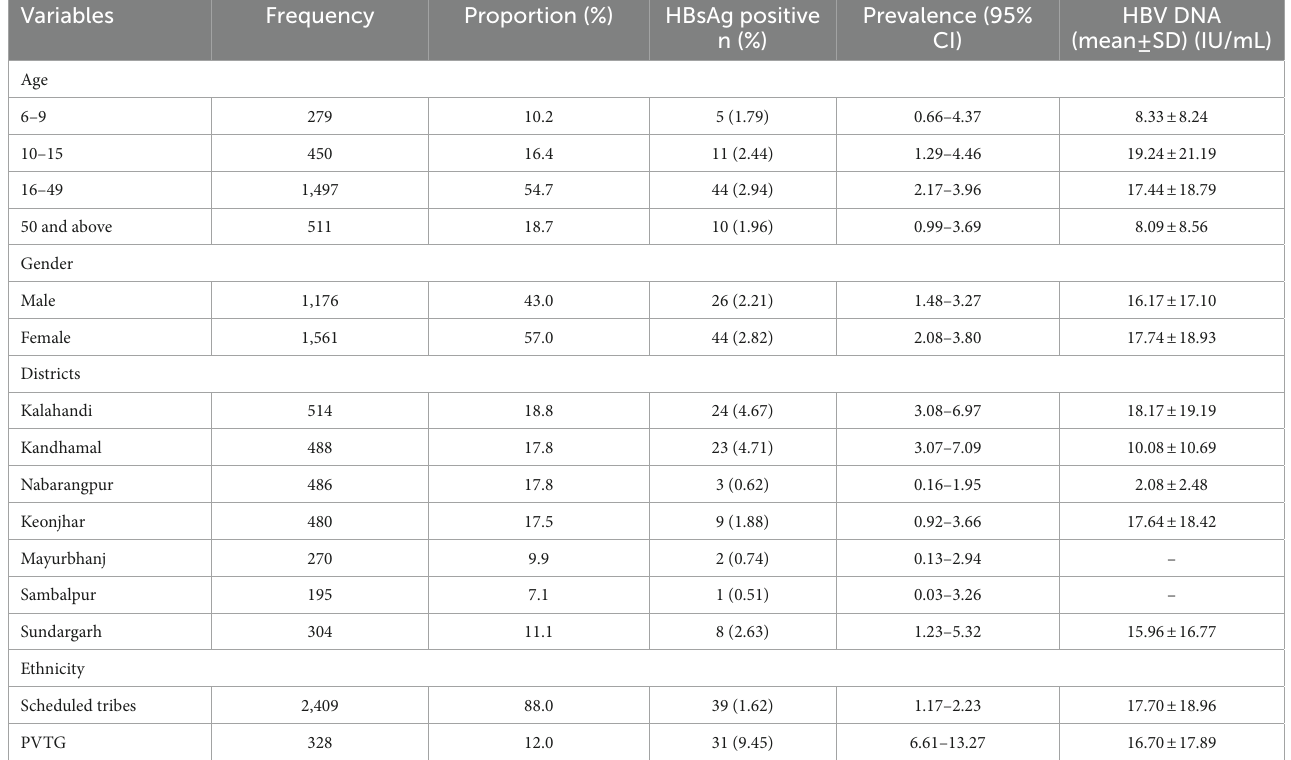
TABLE 1 Demographic details of the participants